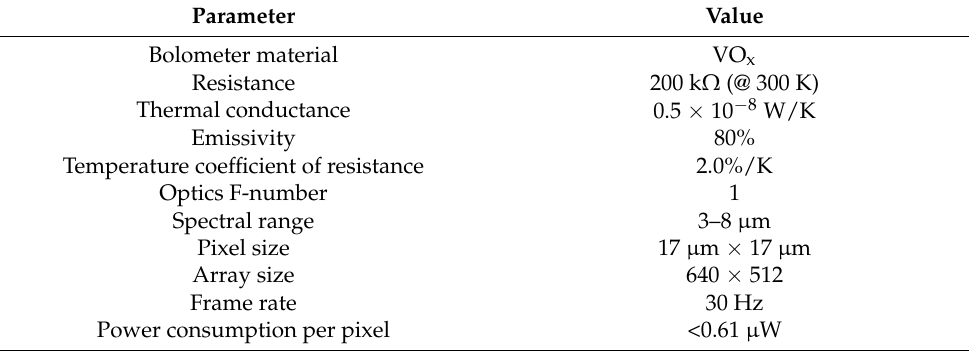
Table 1. Design parameters and characteristics of the target bolometer and the